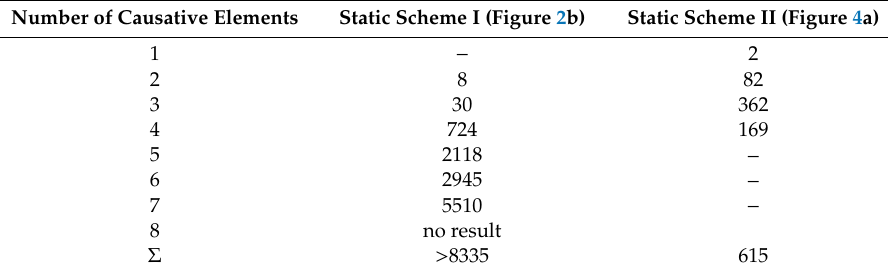
Table 2. Kinematically admissible failure mechanisms for truss “A”.